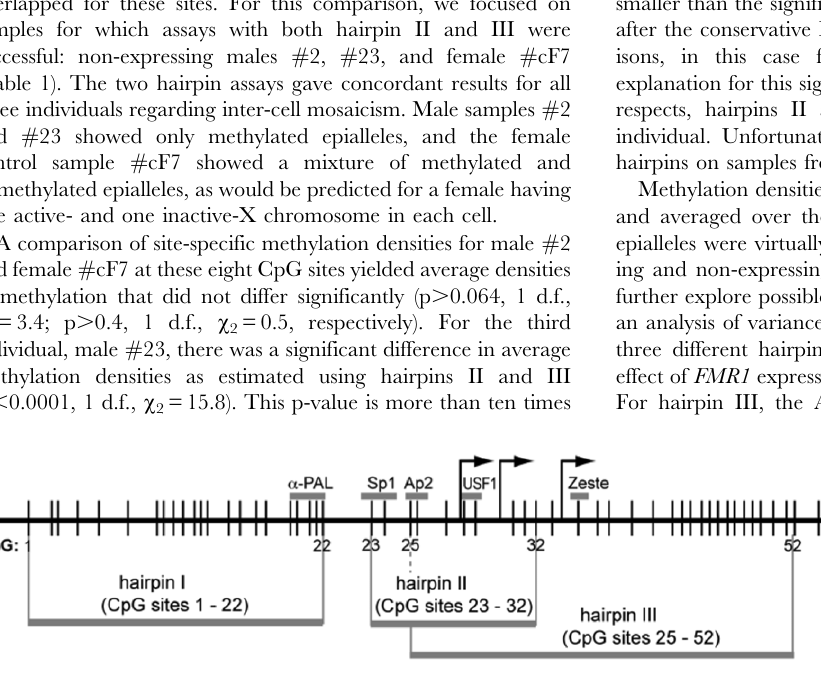
Figure 3. Three separate hairpin–bisulfite PCR assays for the FMR1 promoter. Three hairpins were developed to analyze a total of 52 CpG dyads representing 104 CpGs on both strands of the FMR1 promoter. Small vertical lines depict the distribution of CpG dyads present within the core region of the human FMR1 promoter and the adjacent track of CGG repeats. Horizontal gray bars above the CpG plot indicate the location of binding sites for transcription factors and the position of the CGG repeat. Arrows depict three initiation sites for transcription of FMR1 .